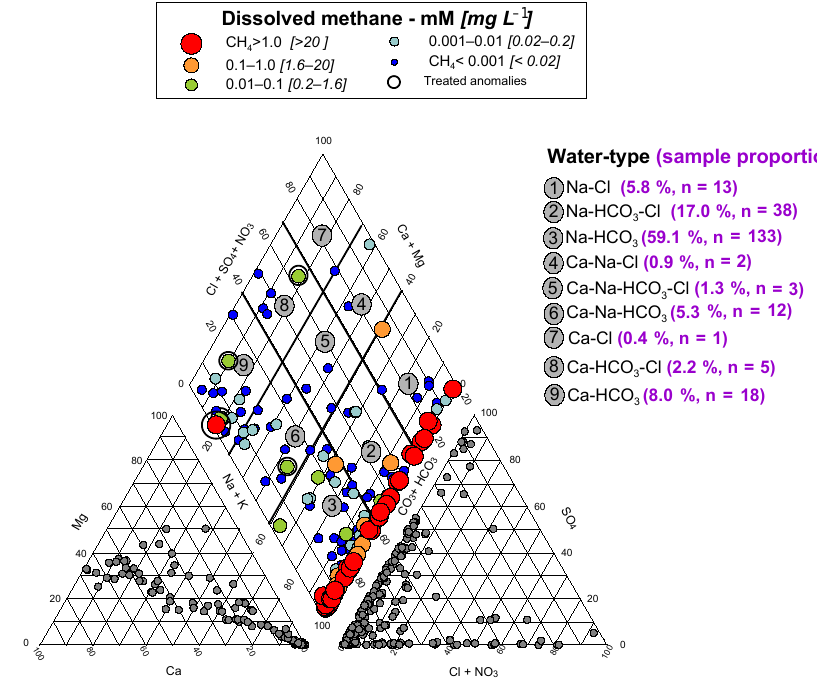
Figure 2. Piper diagram and water type classification of groundwater samples from the GOWN network ( n = 221).